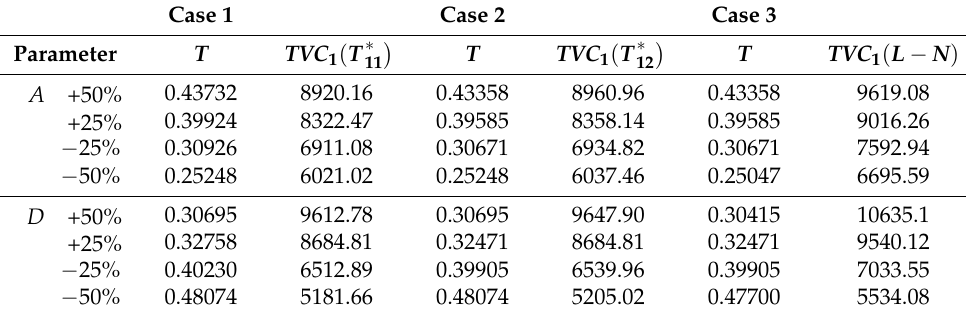
Table 4. Results of Example 1 for three trade credit